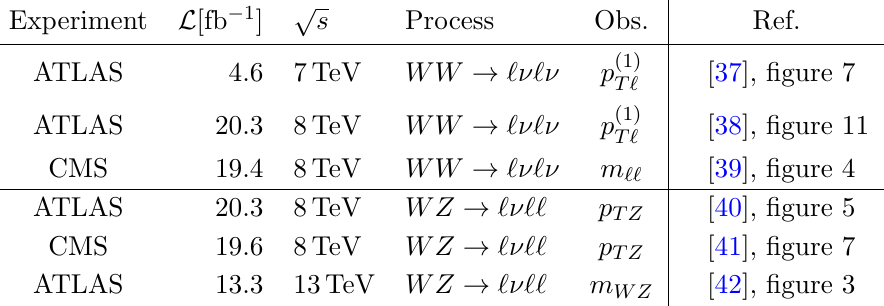
Table 1 . Data used to extract the current LHC